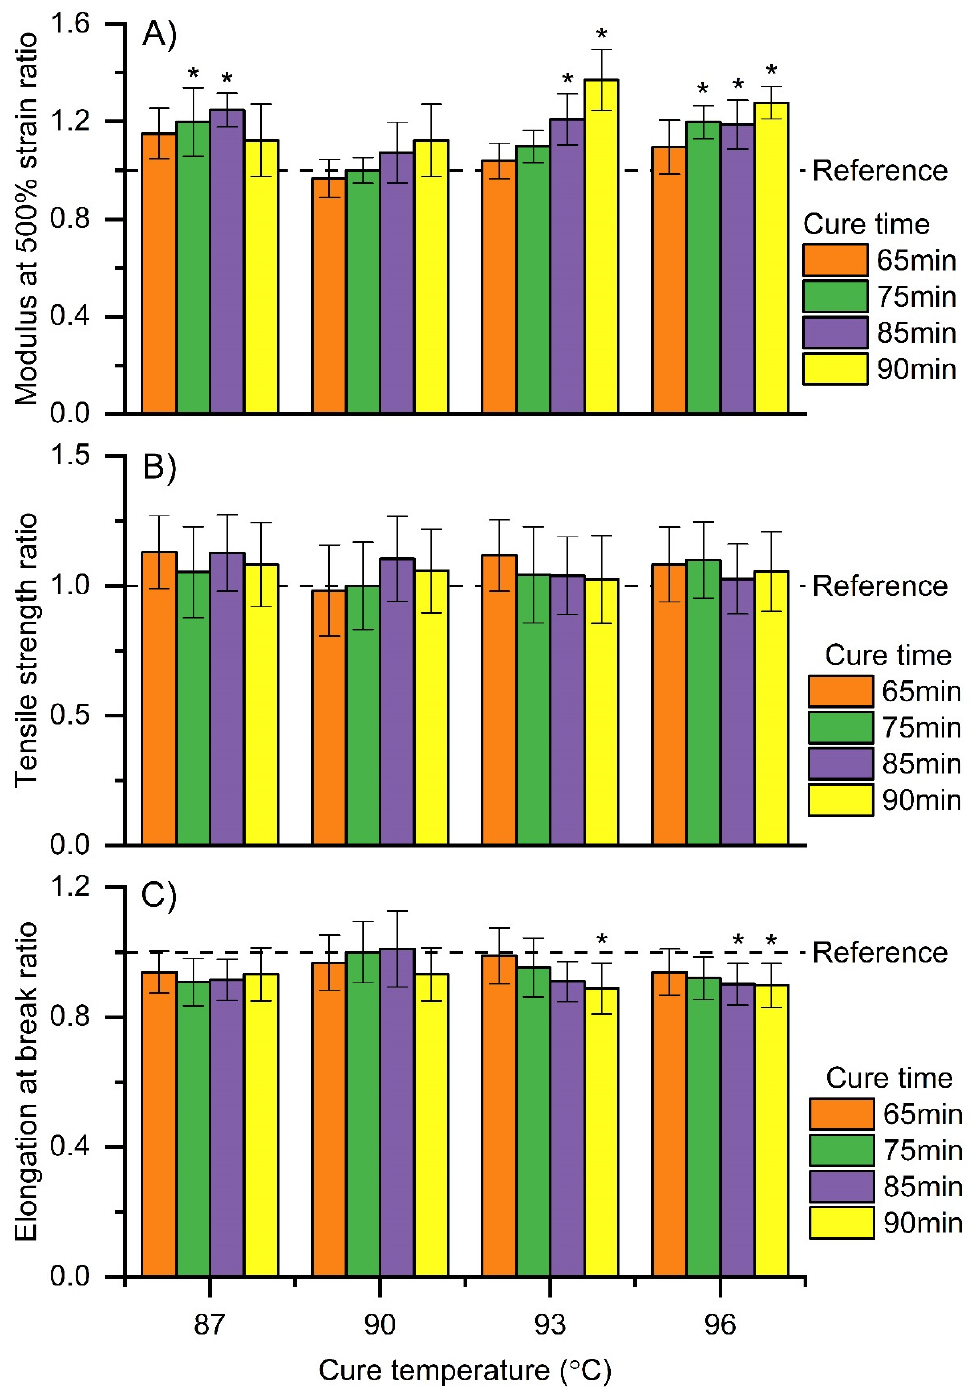
Figure 9. Ratios of mechanical performance of dipped films made with 150 PHR Bi 2 O 3 versus reference films made with 150 PHR Bi 2 O 3 loading and cured at 90 ° C for 75 min as a function of curing temperature and different cure times. ( A ) Modulus at 500% strain ratio, ( B ) tensile strength ratio, and ( C ) elongation at break ratio. All films contained 150 PHR Bi 2 O 3 and were dipped with a 10 s dwell time. Results are expressed as means ( n = 10) ± 1 s.d. Treatments with tensile properties significantly different to the control group are marked with a star (*).